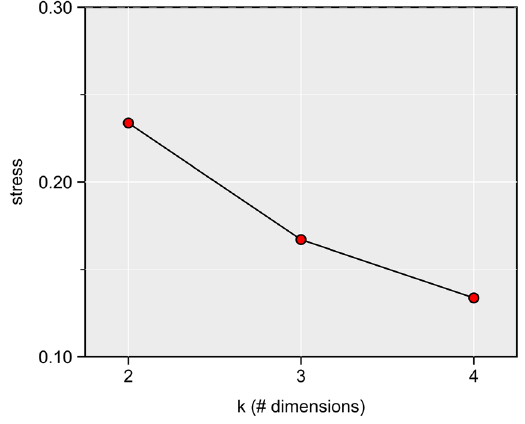
Figure 4. NMDS scree plot showing stress for different values of